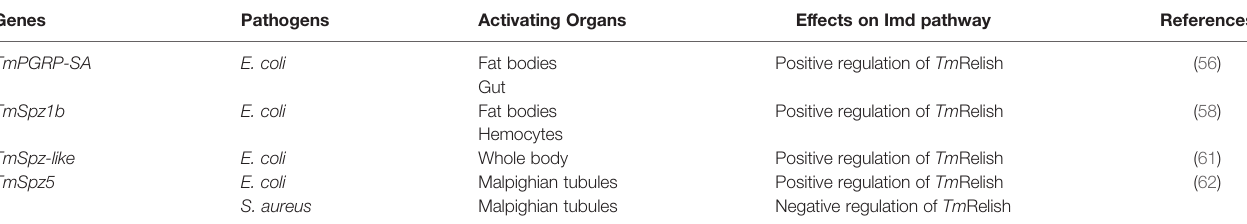
TABLE 3 | Summary of Toll pathway compartments affecting the regulation of Imd signaling in T. molitor